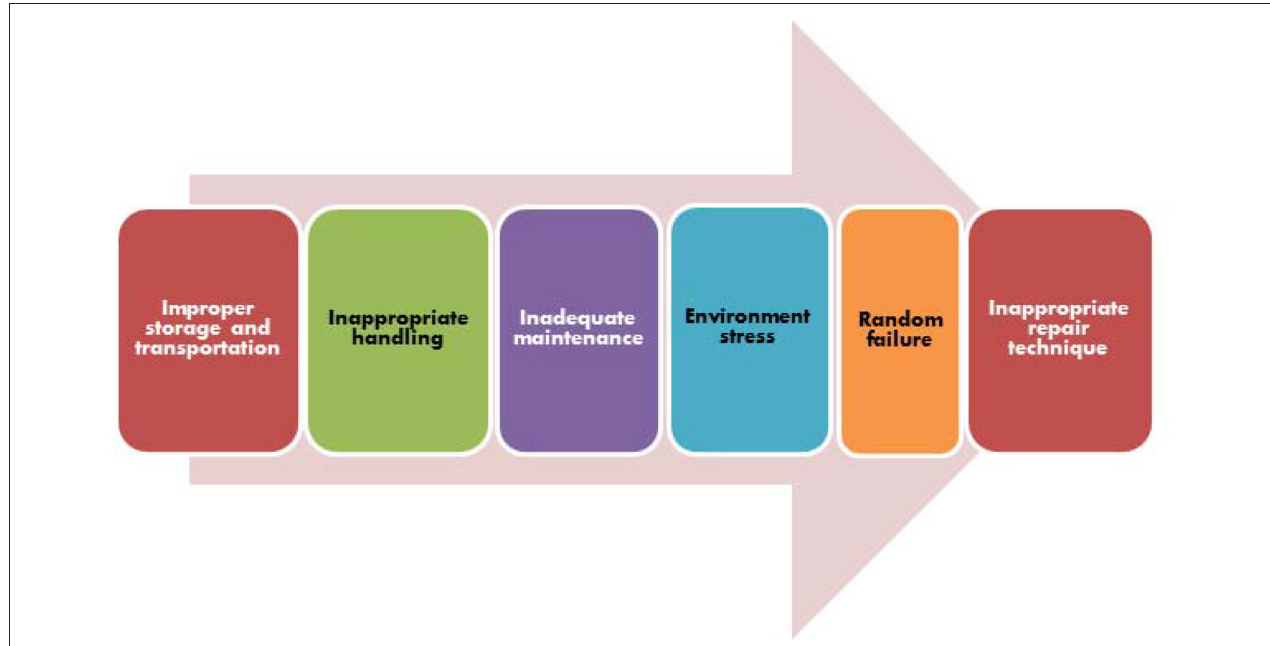
FIGURE 1 | Common causes for biomedical equipment